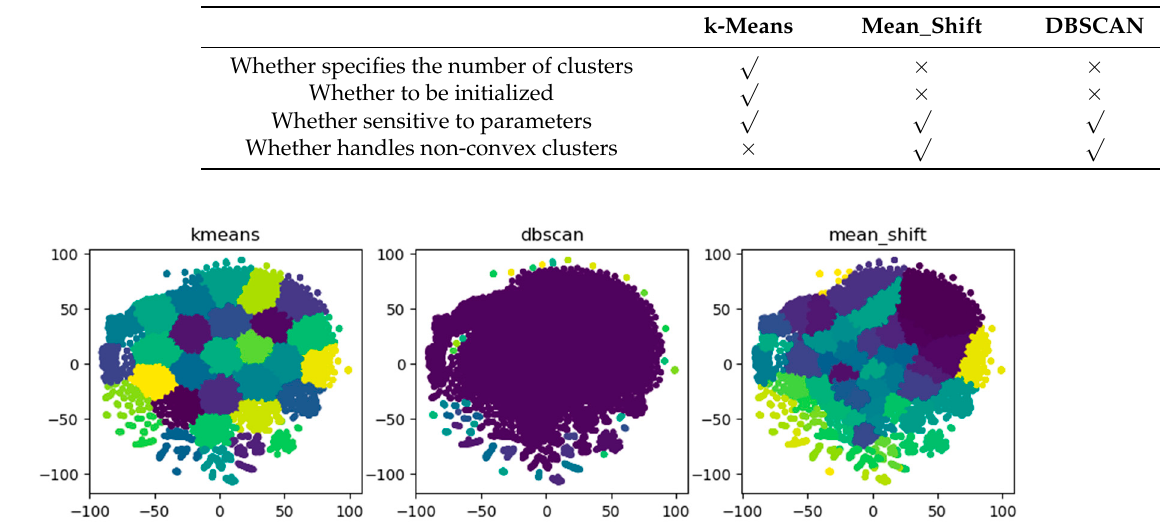
Figure 5. Group detection of three clustering algorithms.